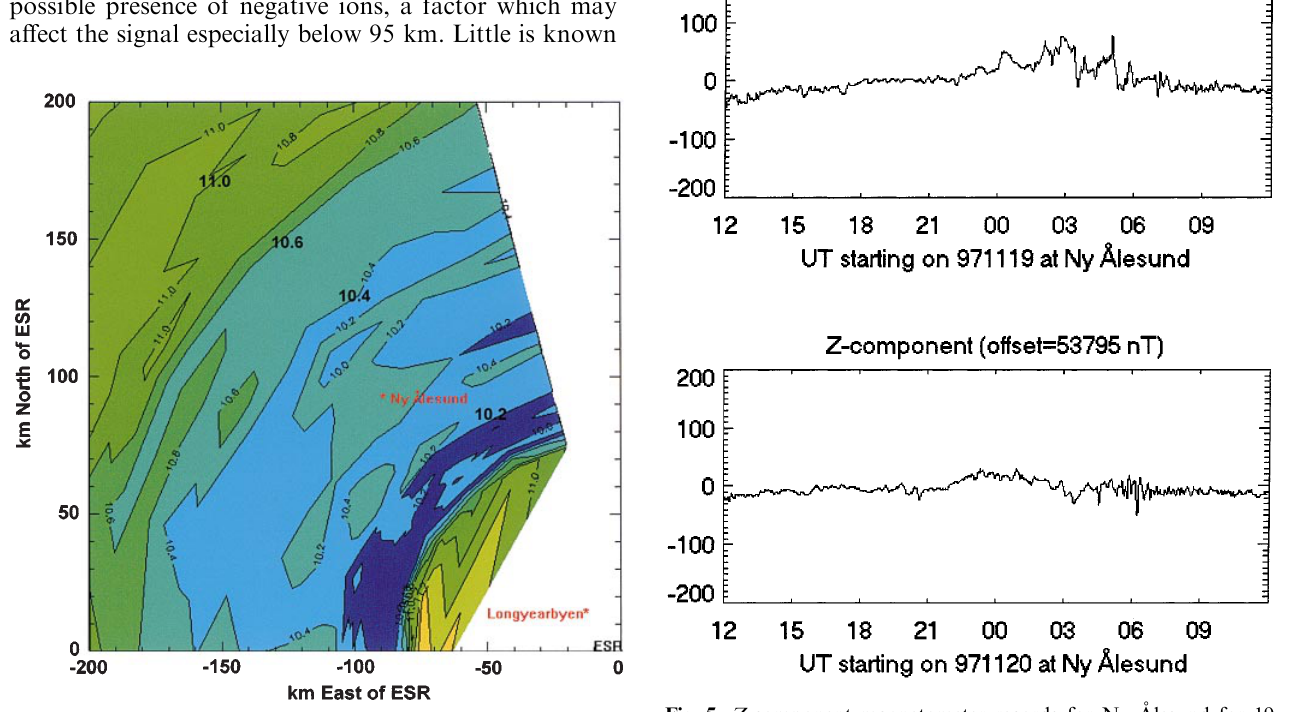
Fig. 4. As for Fig. 3 but for 20 November, 1997. Period of measurement was 1409-2010 UT